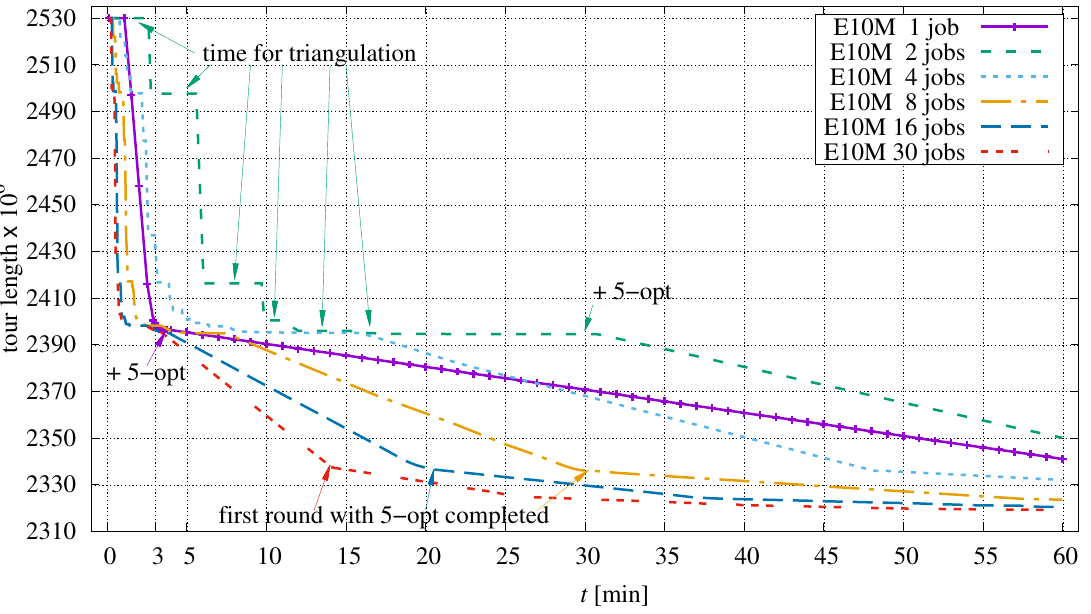
Figure 16. Progress of optimization dependent on the number of parallel jobs in application to E10M.0. The optimization starts with an initial tour of length 2529955468 provided by